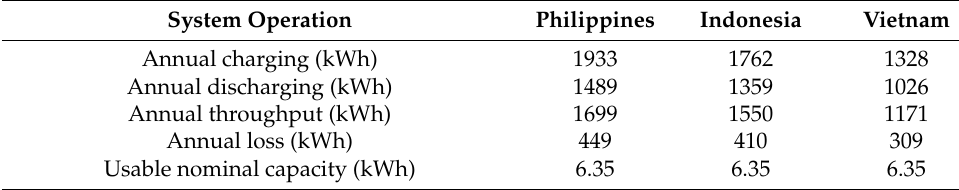
Table 12. Comparison of the RBESS operation performance in the three countries.